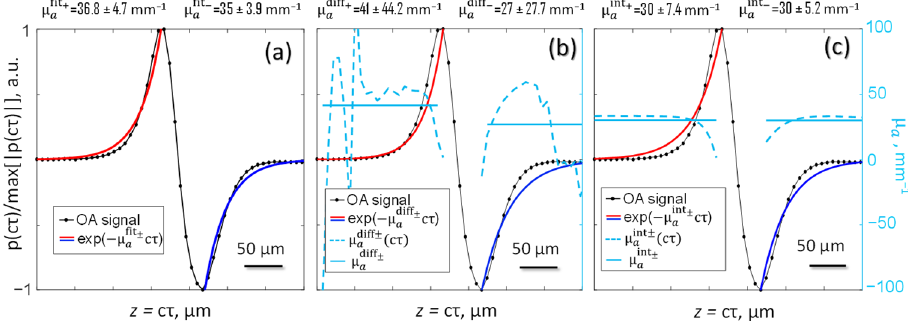
Figure 6. Methods of quantitative OA measurements by means of: ( a ) exponential interpolation, ( b ) differentiation, ( c ) integration of the measured OA signal.